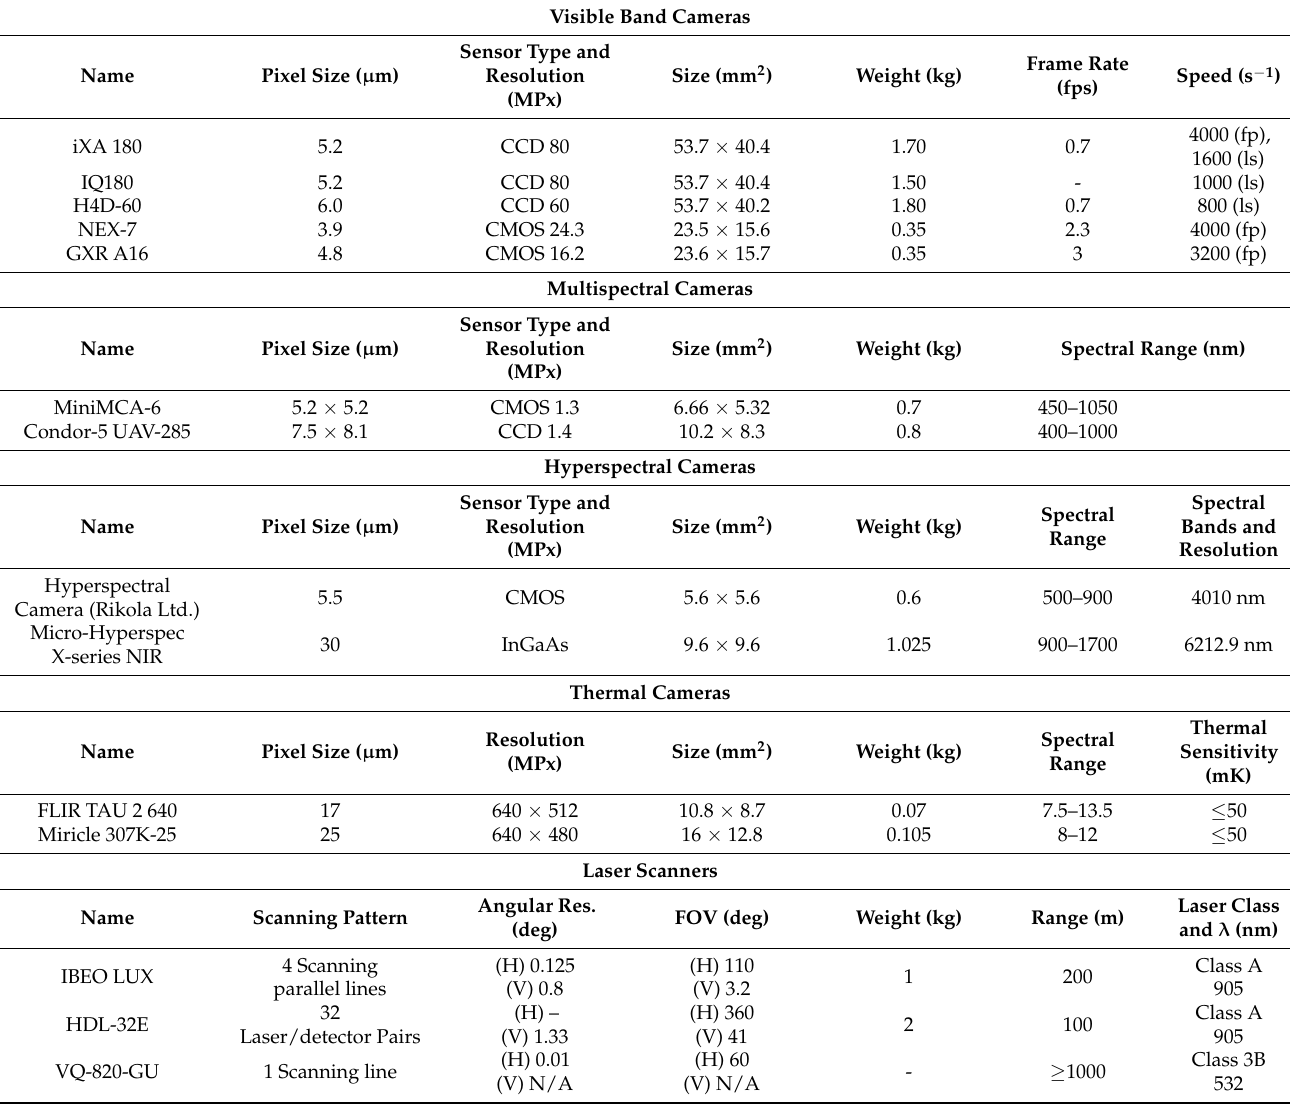
Table 2. Representative cameras for